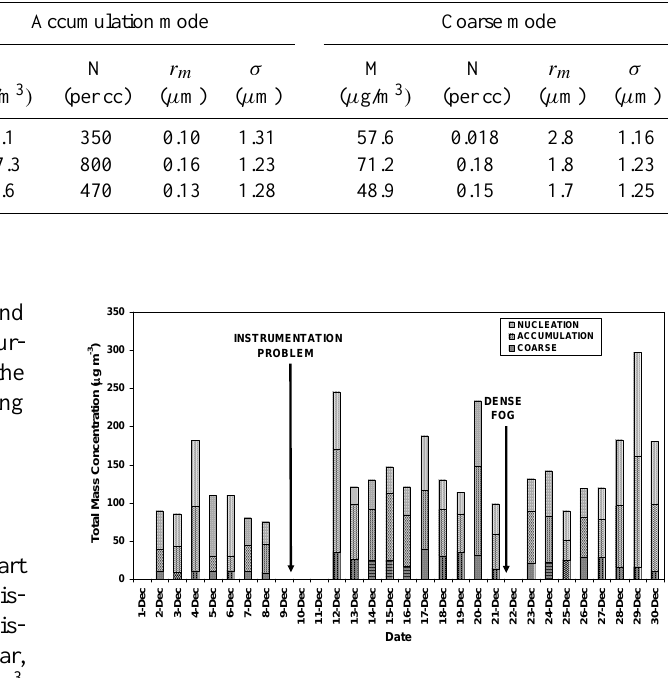
Table 1 gives the aerosol number concentration N in cm − 3 , r m and σ for the three